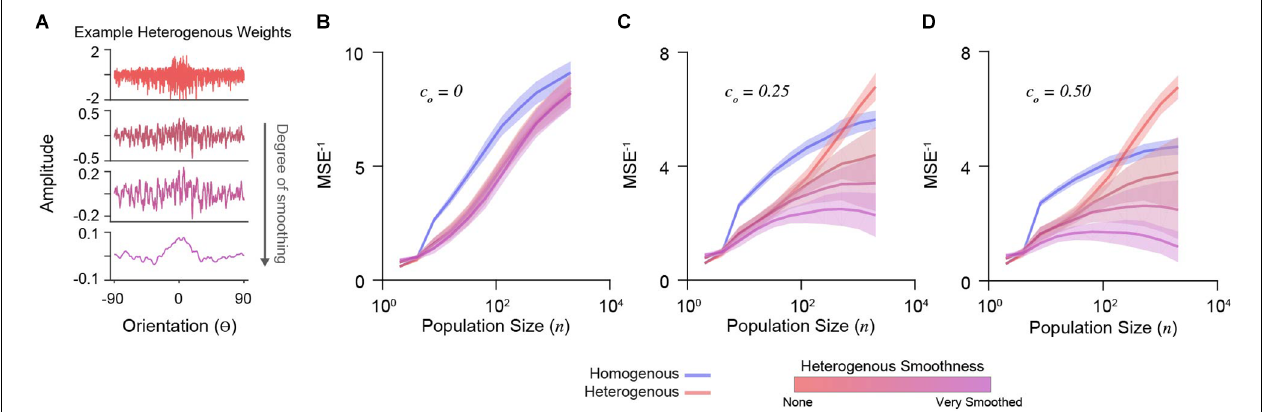
FIGURE 3 | Decoder performance of heterogeneous input populations depends on population size, correlations, and weight diversity. (A) Example weight distribution for a decoder neuron reading out a heterogeneous input population (top). Shown are the effects of progressively smoothing weights. Smooth parameters (see “Methods” Section) from top to bottom: (0, 0), (0.1, 1), (0.2, 2), (1, 10). The ordinate is orientation preference, restricted between − 90 o and 90 o . (B) Decoder performance (inverse mean-squared-error) plotted for homogenous and heterogeneous input populations of increasing size. Simulations here include no correlations ( c o = 0). Shading indicates standard error. (C) Same as in (D) for input populations with moderate correlation ( c o = 0.25). (D) Same as in (B) for input populations with stronger correlation ( c o = 0.50).